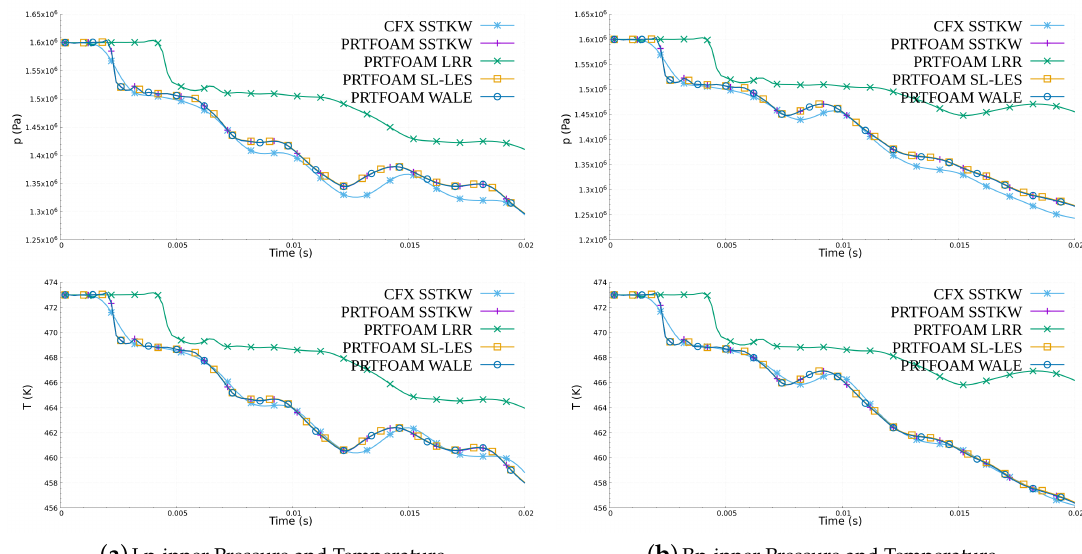
Figure 18. Pressure–time curve and temperature–time curve of the simulation results of different models at the ( a ) Lp-inner and ( b ) Rp-inner sampling point inside the PRT. The curves of PRTFOAM SSTKW, PRTFOAM SL-LES, and PRTFOAM WALE basically coincide. The simulated dumping process of PRTFOAM LRR is slower than that of other